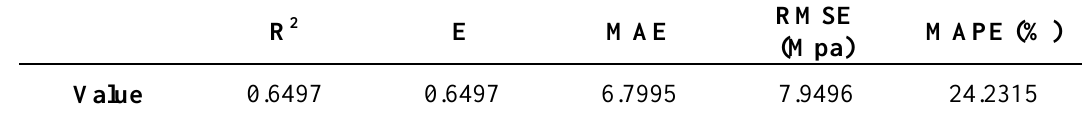
R 2 , E, MAE, RMSE, and MAPE Values of MLR